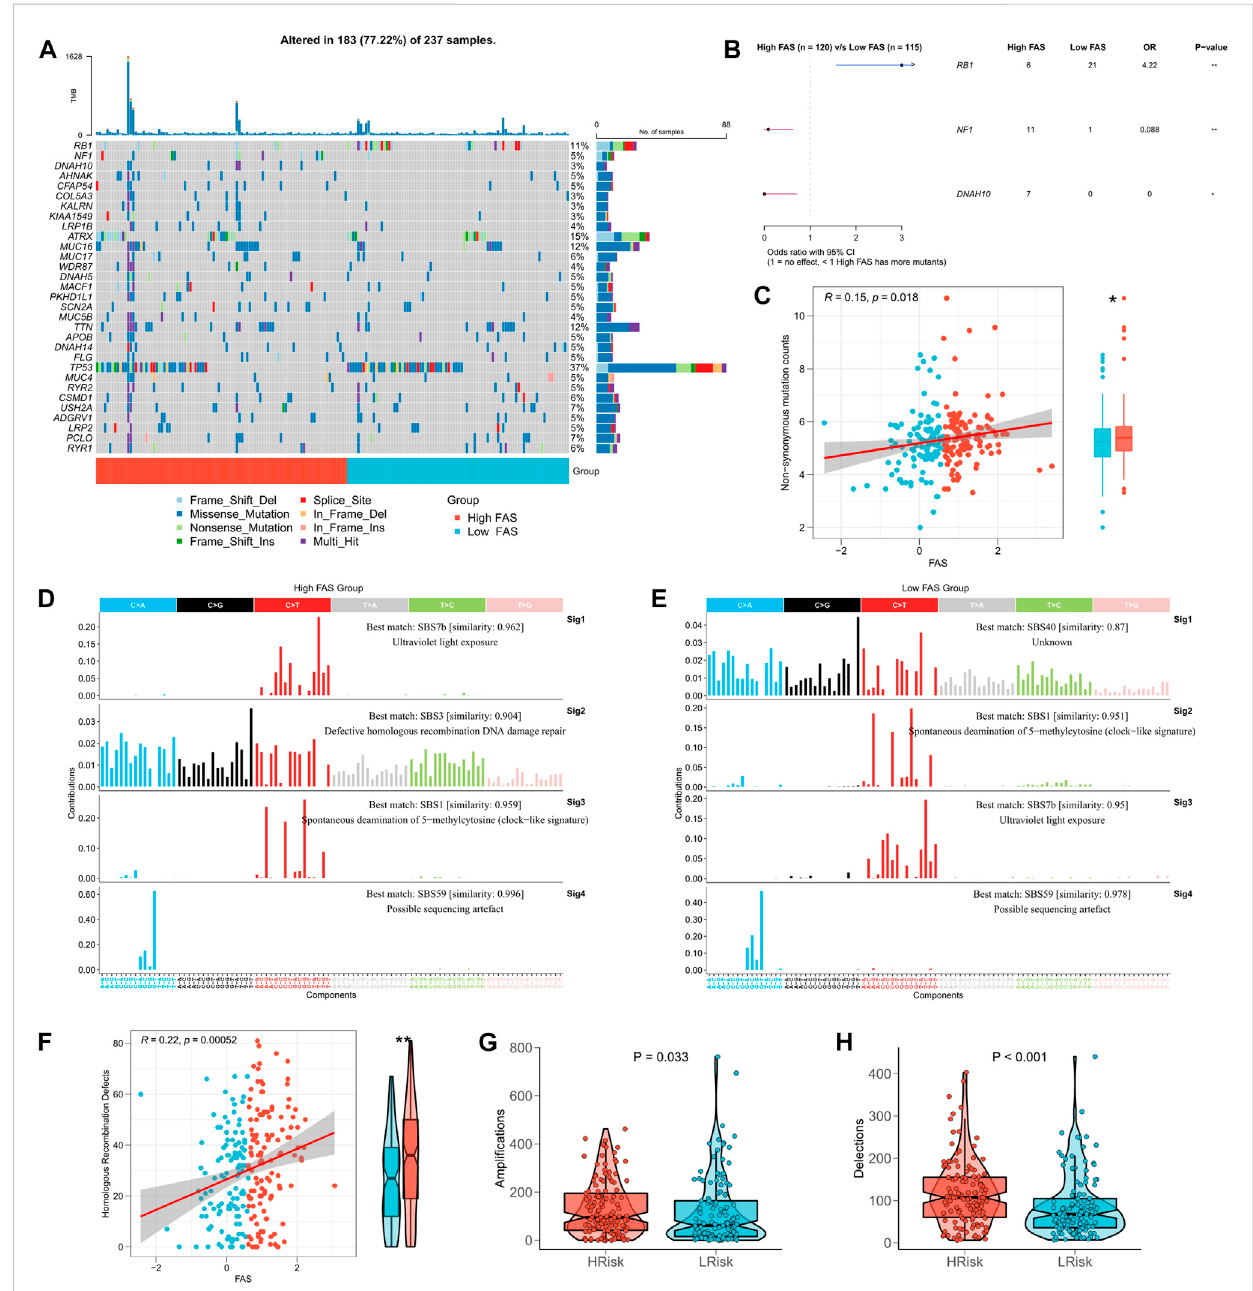
FIGURE 7 Association between FAS and tumor mutation burden. (A) TMB difference between the high- and low-FAS groups. (B) Genes with signi fi cant mutations among thehigh-and low-FAS groups ( p < 0.05). (C) The relationshipbetween FASand non-synonymous mutation counts. (D,E) Homologous recombination repair in STS with different FAS. (F) The difference in homologous recombination defects between distinct FAS groups. (G,H) The copy number variation was signi fi cantly positively associated with